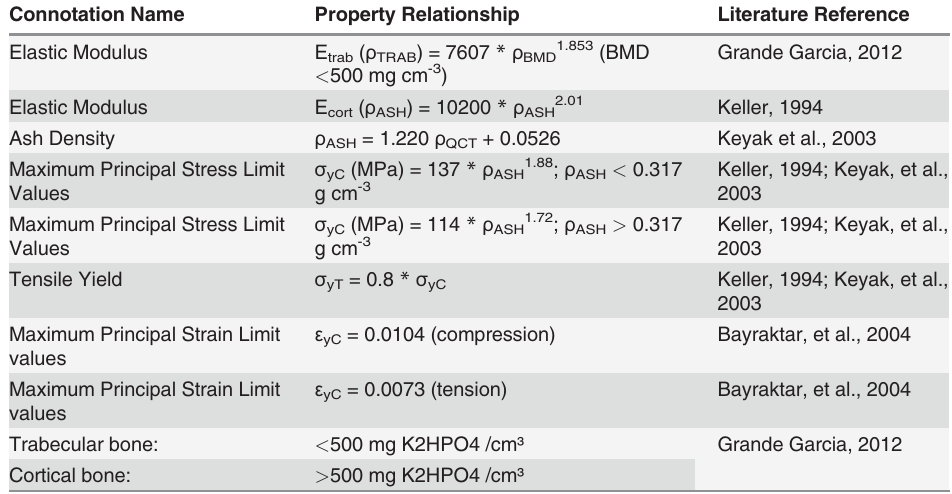
Table 2. Threshold values and property relationships adapted from the literature: Elastic property relationships for tensile and compressive testing, limit values for maximum stress and strain and threshold values used for bone mineral